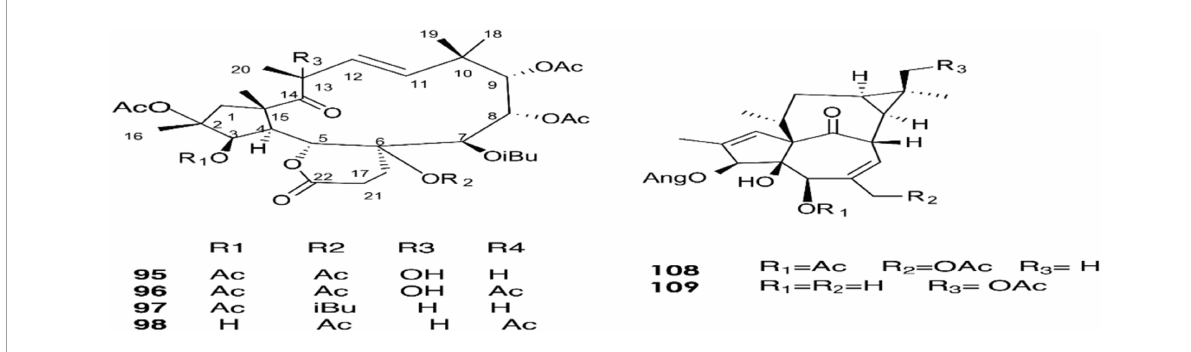
FIGURE5 Structure of chemicals compounds ( 95-98 ) and ( 108-109) (Marco et al., 1999; Esposito et al., 2016).